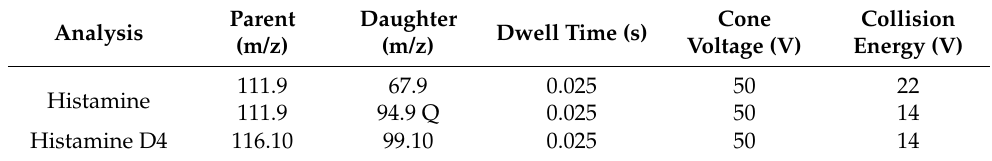
Table 2. Transitions and acquisition parameters used in MRM (Multiple Reaction Monitoring) mode.